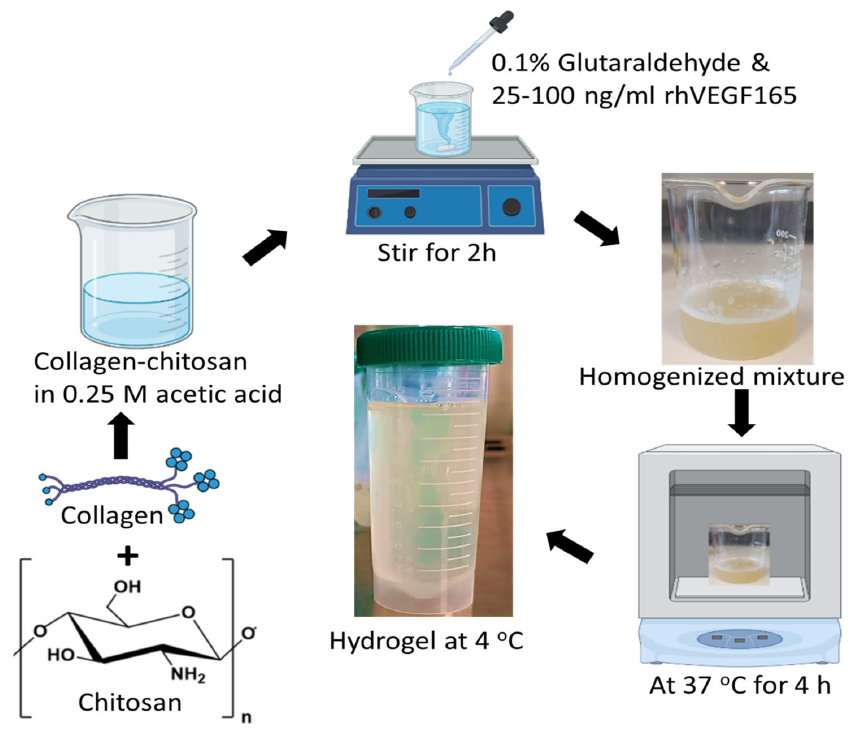
Figure 1. Schematic representation of collagen–chitosan hydrogel fabrication with di ff erent contents of VEGF. of